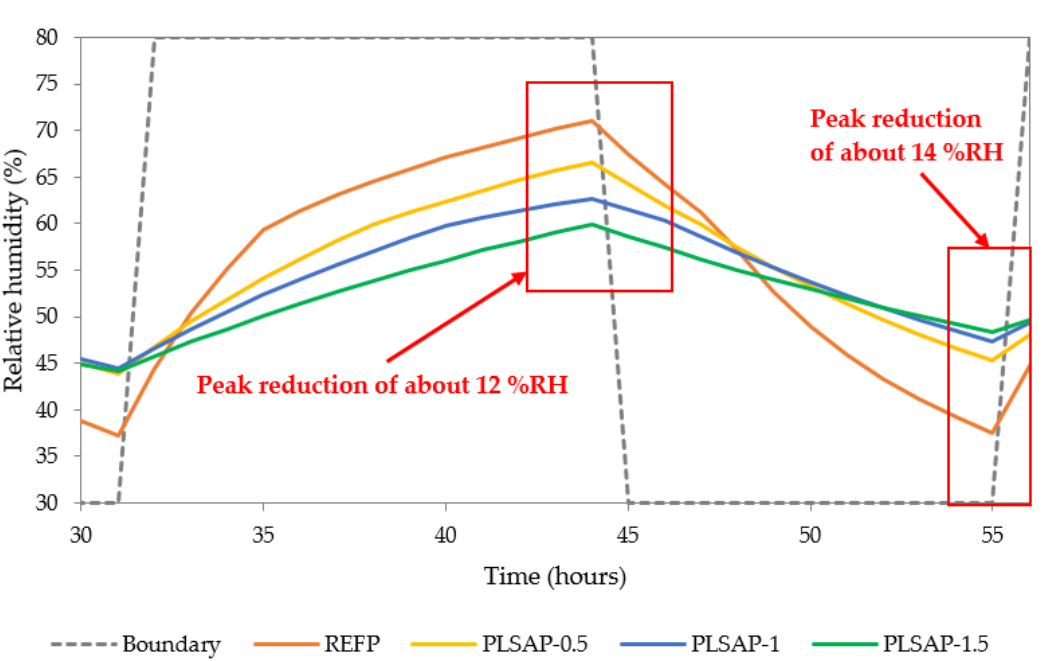
Figure 4. Simulation of relative humidity variations.